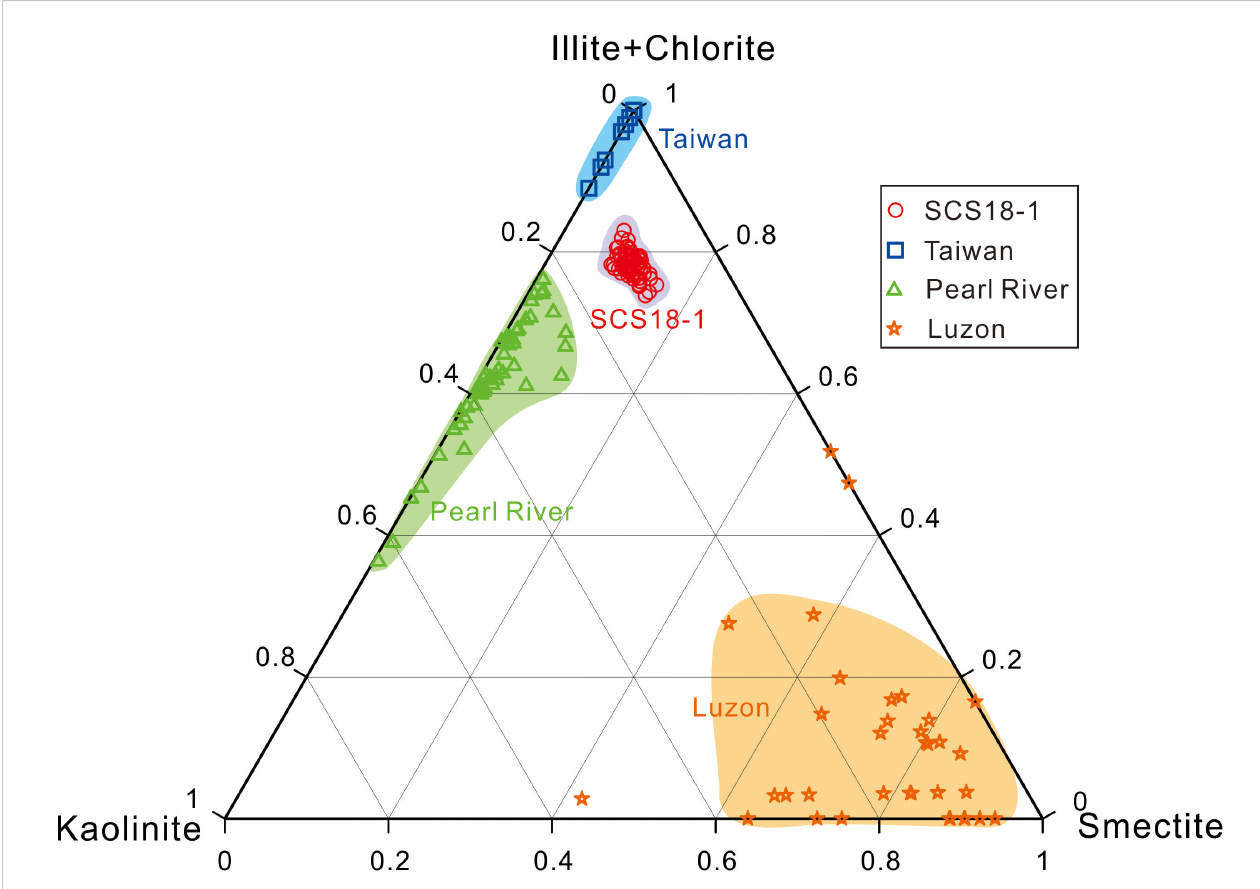
FIGURE 6 Ternary diagram of the major clay mineral groups illite+ chlorite, kaolinite, and smectite. Data of the Pearl River are from Liu et al. (2007); data of the Luzon rivers are from Liu et al. (2009); data of the Taiwan River are from Li et al. (2012); the referenced data have been converted according to Biscaye